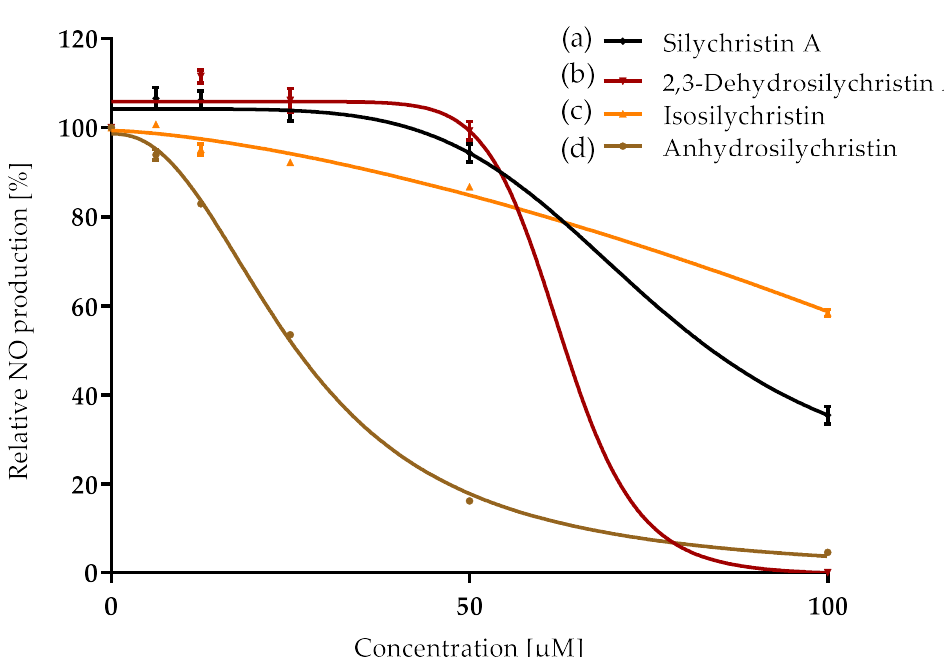
Figure 4. Relative nitrite oxide production as the first marker of inflammation affected by silychristin derivatives: ( a ) silychristin A; ( b ) 2,3-dehydrosilychristin A; ( c ) isosilychristin; ( d ) anhydrosilychristin. Data are presented as the average of three measurements with respective standard error of the mean.